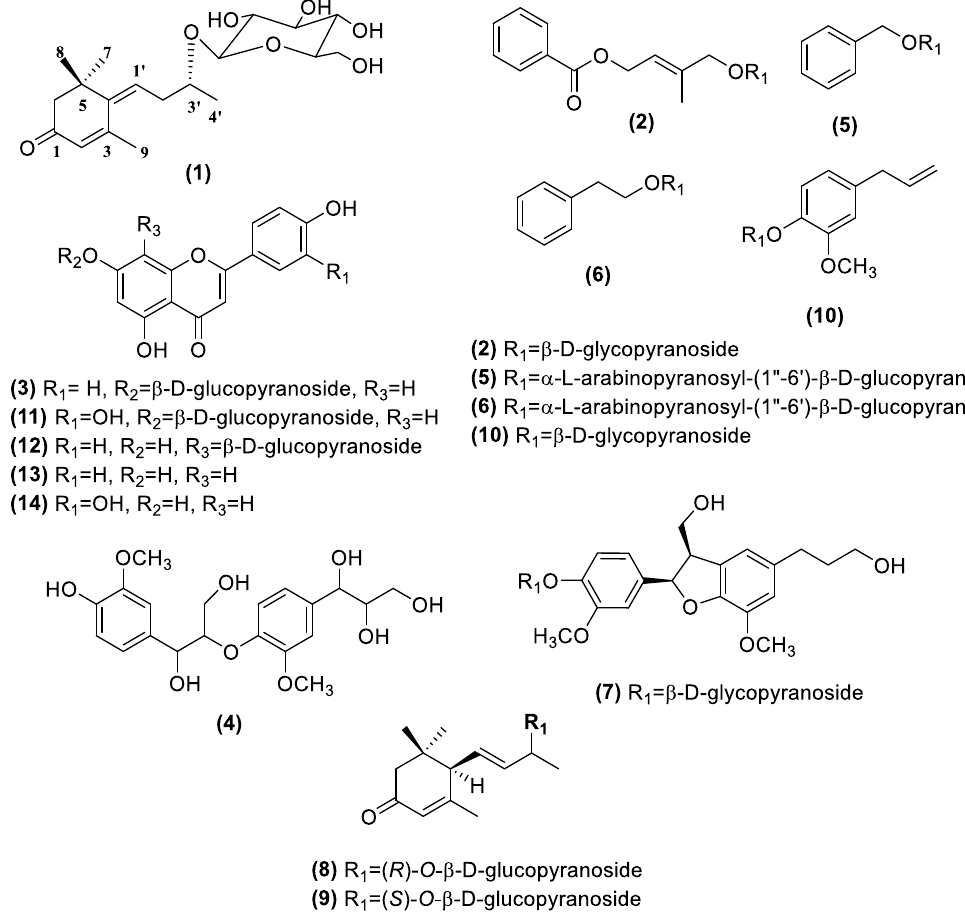
Figure 1. Chemical structures of compounds 1 – 14 isolated from the active fraction of Humulus japonicus (HJF).